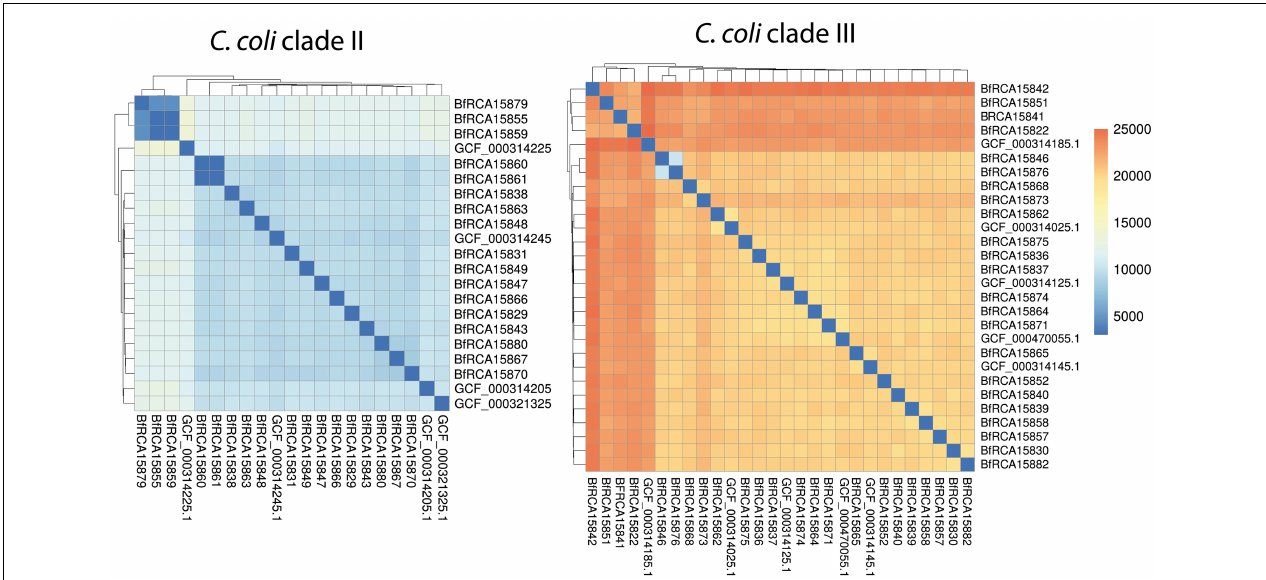
FIGURE 3 | Pairwise SNP analysis show that C. coli clade II isolates were less diverse than C. coli clade III isolates. Heatmap color code of pairwise number of SNPs is shown on the right. NCBI closed genomes of C. coli clade II and clade III are included for comparison.